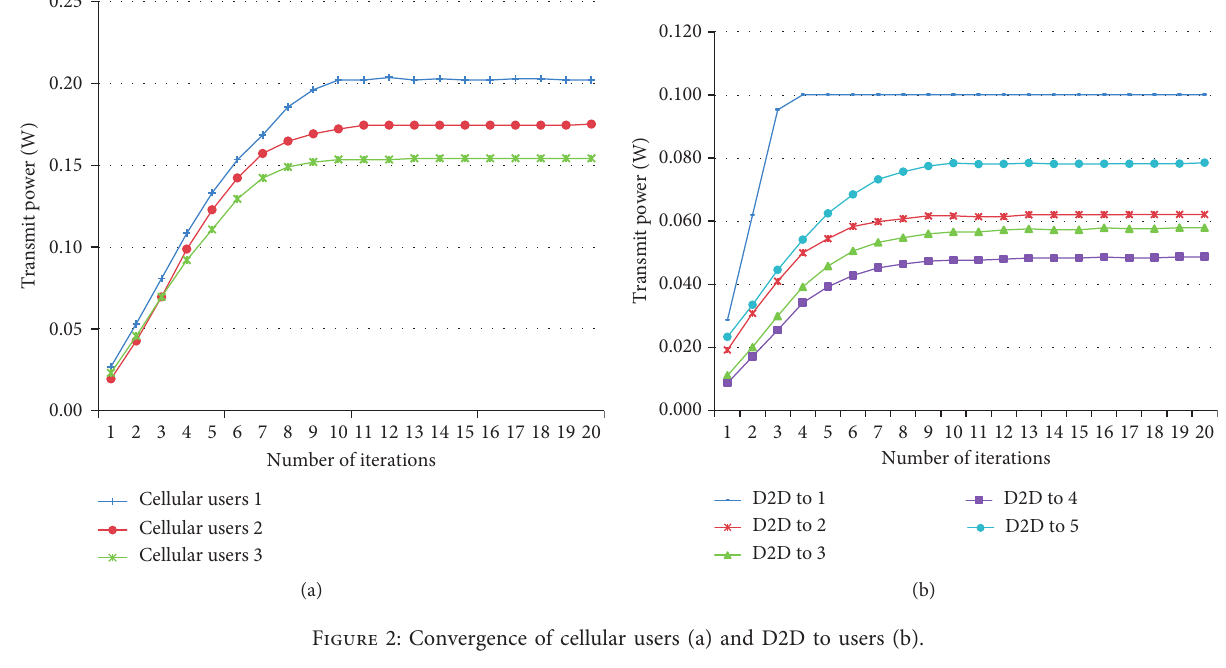
Figure 2: Convergence of cellular users (a) and D2D to users